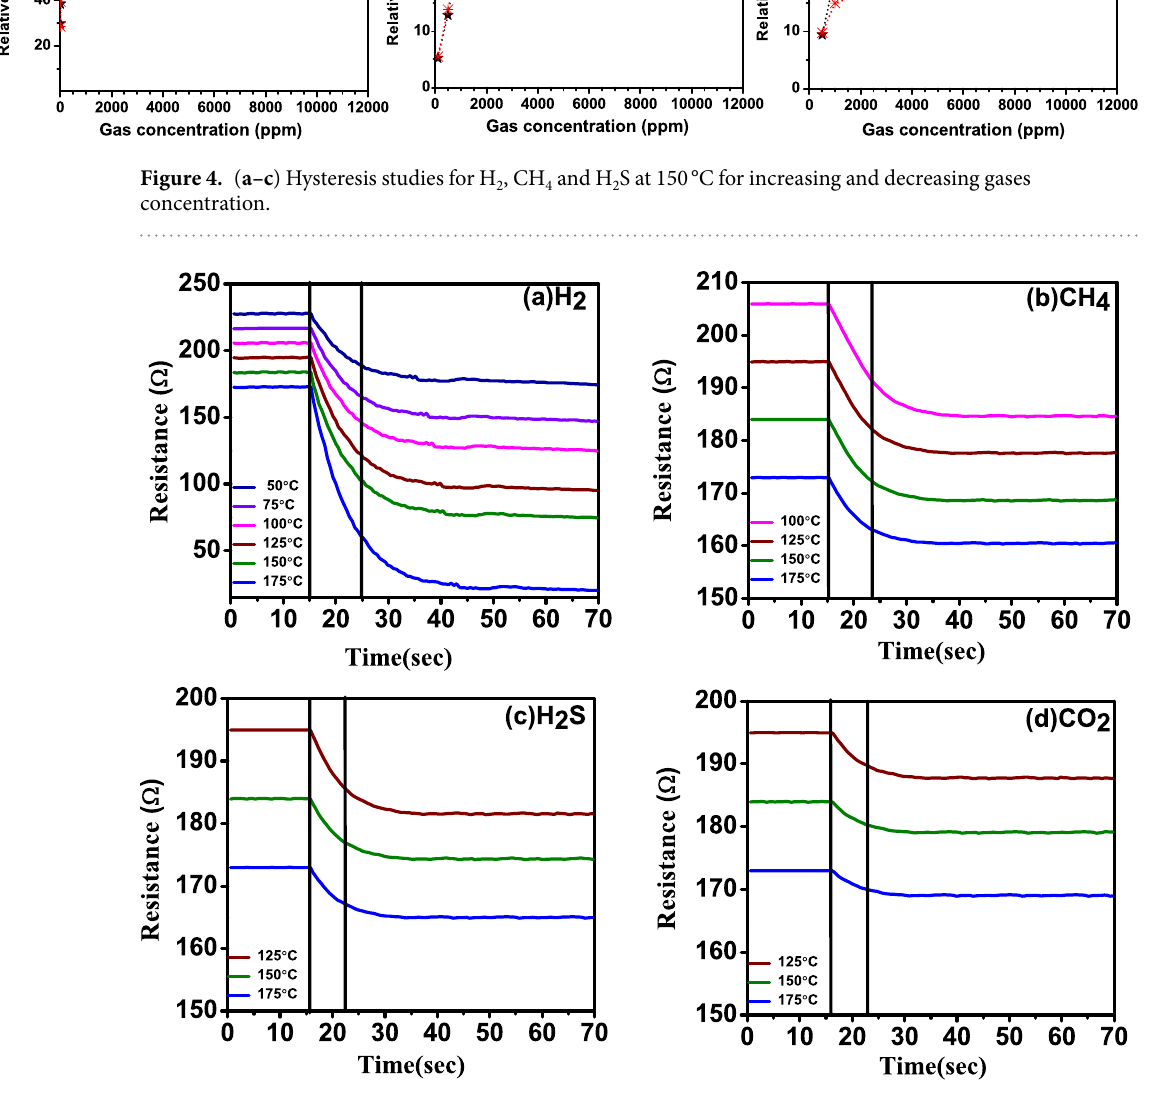
Figure 5. Resistance verses time curve for ( a ) H 2 , ( b ) CH 4 , ( c ) H 2 S and ( d ) CO 2 gases with 1% concentration at various